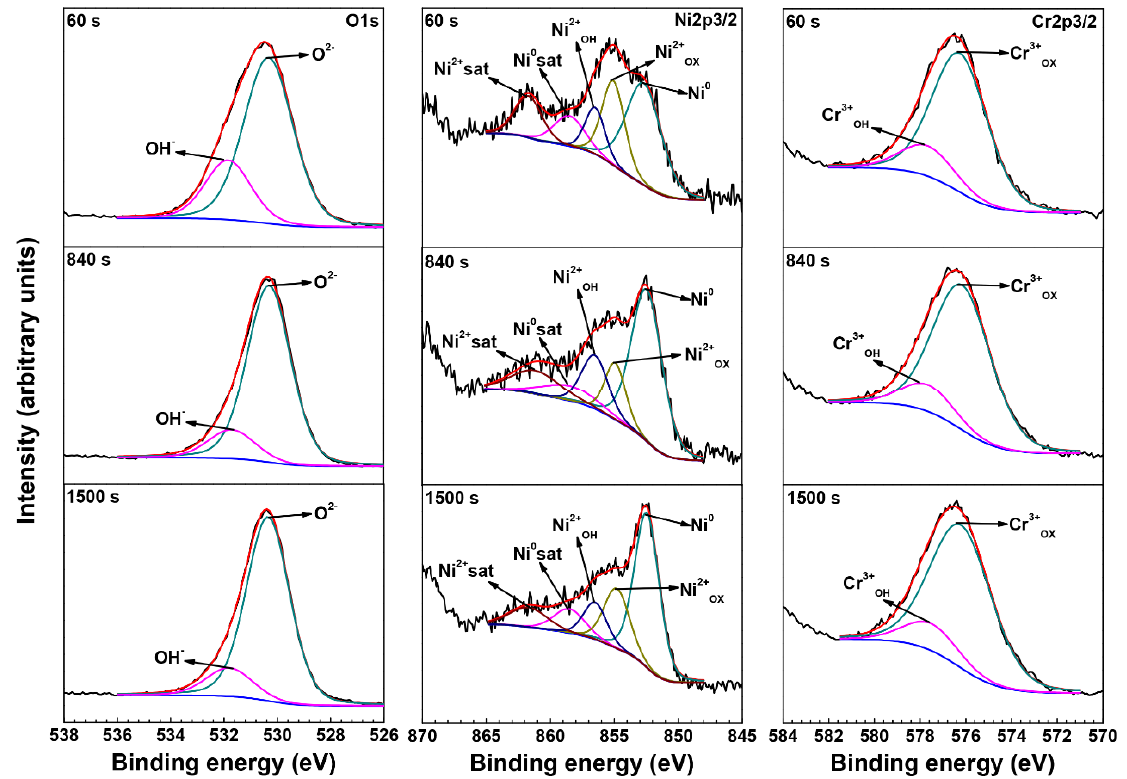
Table 2. Binding energies of XPS peaks.